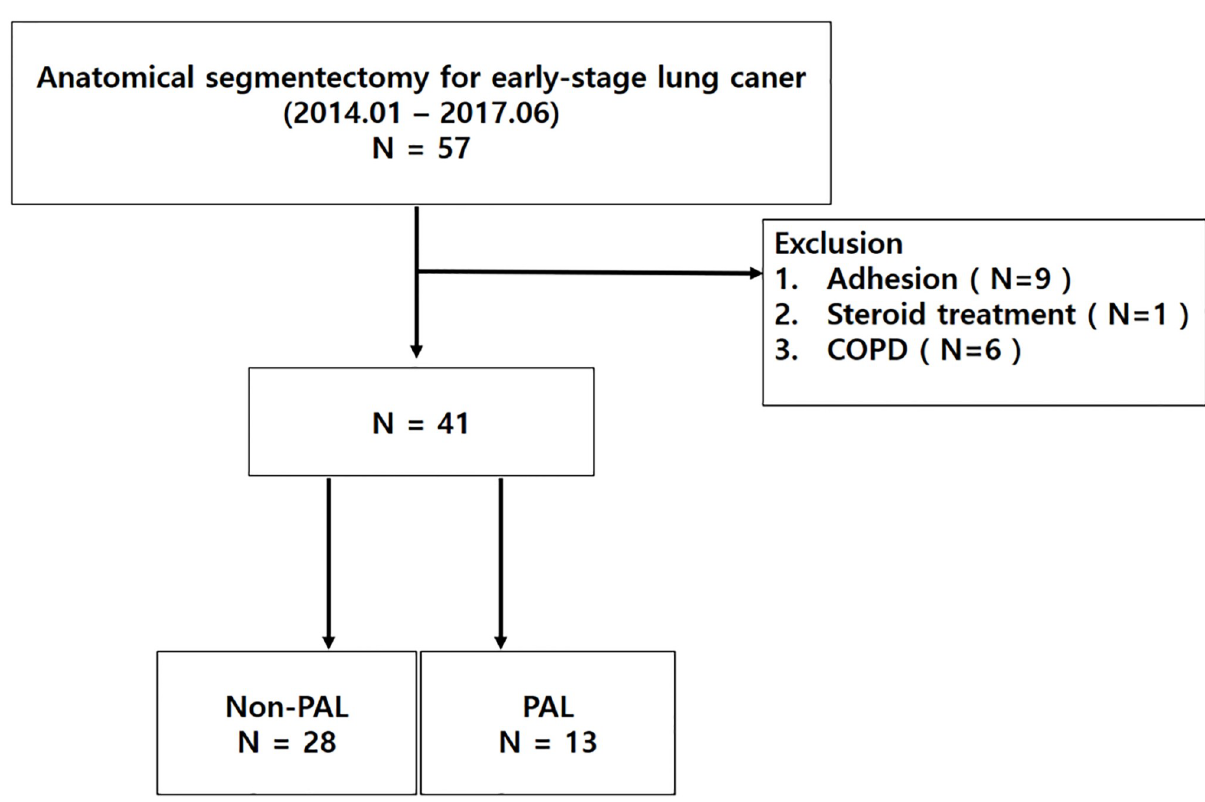
Fig 1. Flowchart for patient